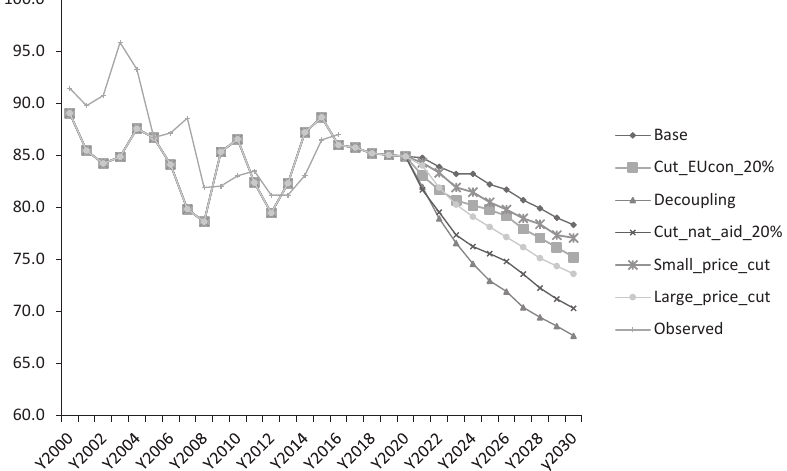
Fig. 6. Simulated beef production (million kg) for the whole country in different